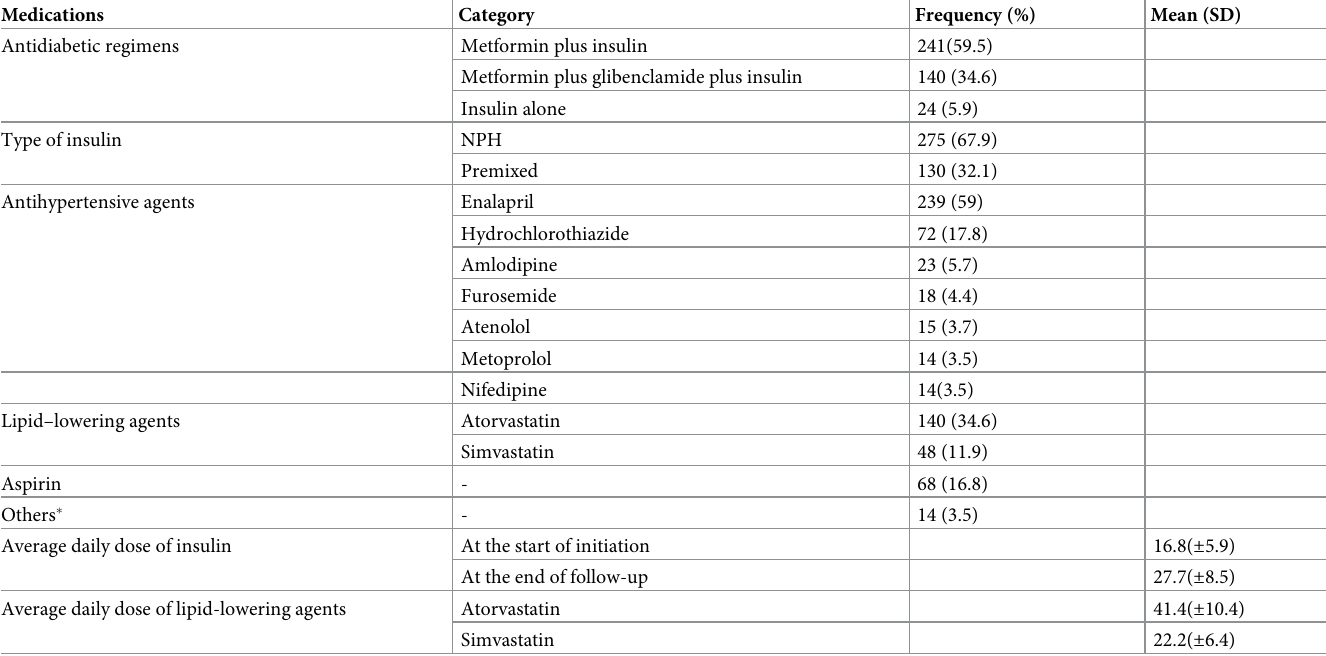
Table 2. The distribution of medications in NPH and premixed insulin-initiated T2DM patients.